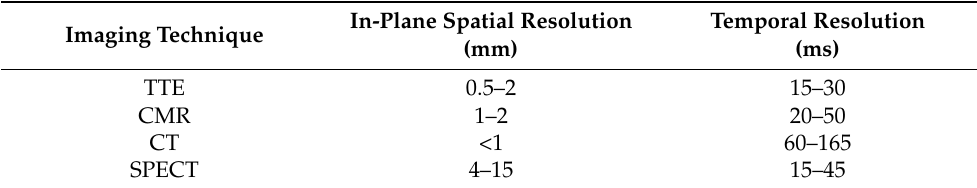
Table 2. Values of spatial and temporal resolution for different cardiac imaging techniques. TTE = transthoracic echocardiography, CMR = cardiac magnetic resonance, CT = computed tomography, SPECT = single photon emission computed tomography [27,30,40].